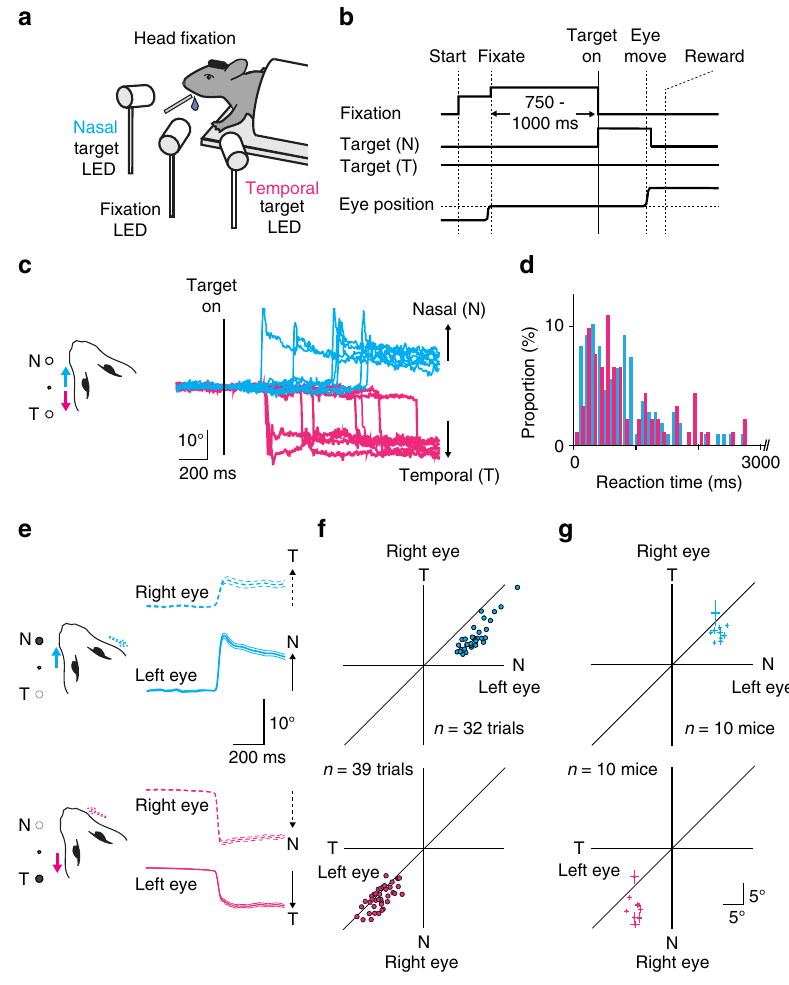
Fig. 1 A visually guided eye movement task in mice. a The experimental design. Three LEDs instructed when and where to move the left eye. b After the mice fi xated the central LED, one of the two LED targets (nasal or temporal) was turned on, and mice were required to shift their left eye toward the target. c Representative eye traces recorded during one behavioral session. Traces are aligned to the target onset. Cyan traces, trials with nasal target; magenta traces, trials with temporal target. d The distributions of reaction times for one animal (cyan, nasal target condition; magenta, temporal target condition). Reaction time range < 3 s (nasal 91.7%; temporal 81.3%) is shown because of the long tail of its distributions. e Average traces for eye movement for both eyes in one behavioral session (nasal, 32 trials, cyan; temporal, 39 trials, magenta). Traces for the left eye, solid lines; right eye, dotted lines. Thick and thin lines represent mean ± s.e.m. f The amplitude of the eye movements for the left and right eyes (cyan, nasal target; magenta, temporal). The same animal as in e . g The average eye movement amplitude is shown for the nasal (cyan) or temporal (magenta) target trials in 10 mice. Error bars indicate